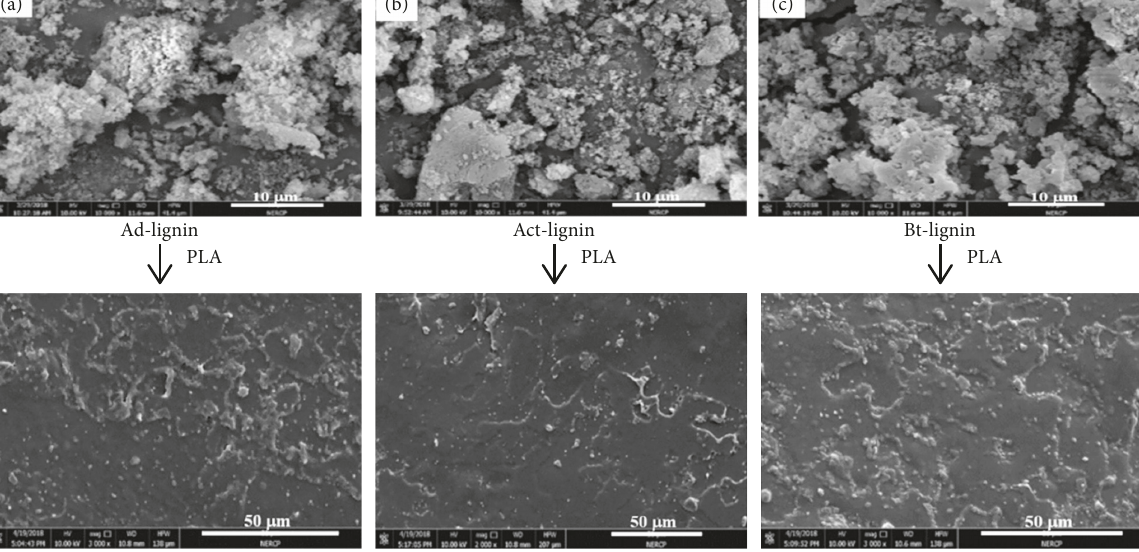
Figure 7: SEM images of biocomposites of chemically modified lignin: (a) PLA/Ad-lignin, (b) PLA/act-lignin, and (c) PLA/Bt-lignin [219]. (Copyright @ 2019 MDPI under CC BY